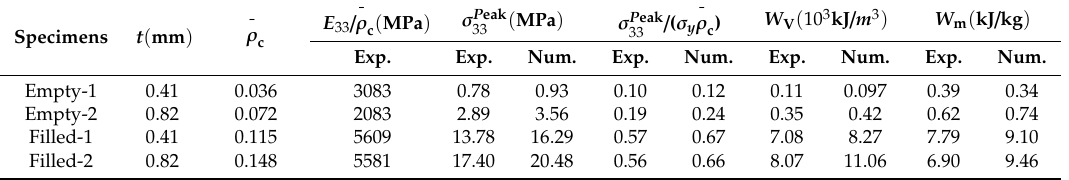
Table 1. Summary of core member thickness t , relative density ρ numerical (Num.) results of specific structural sti ff ness E 33 / ρ (cid:17) compressive stress σ P eak / ( σ y ρ , energy absorption per unit volume W v , and per unit mass W m of c 33